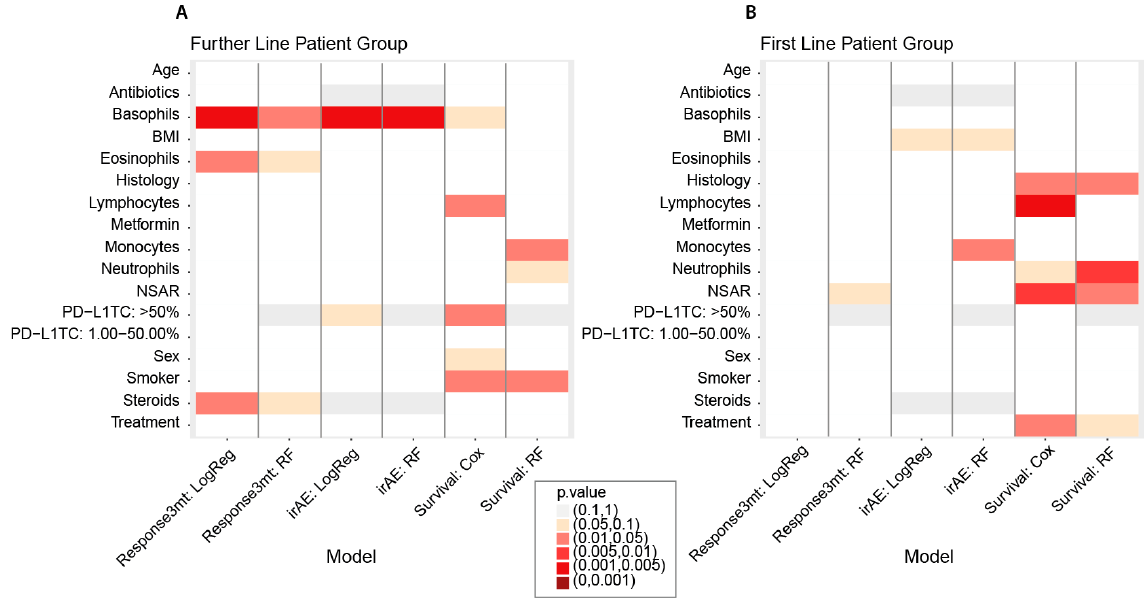
Figure 3. Summary plot of significance of p -values of each predictor in each of the analyses for ( A ) the further-line patient group and ( B ) the first-line patient group. LogReg: logistic regression; RF: random forest; Cox: Cox proportional hazard regression.